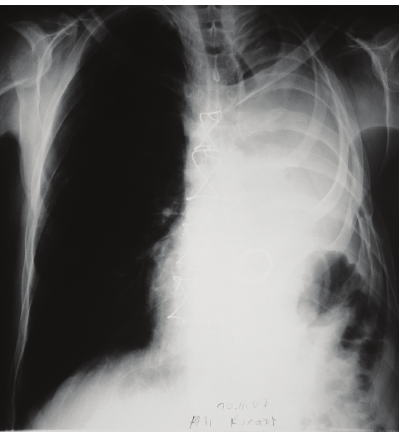
Figure 1: Chest roentgenogram of the patient postoperatively. Note the hyperinflated right lung with leftward displacement of the mediastinal